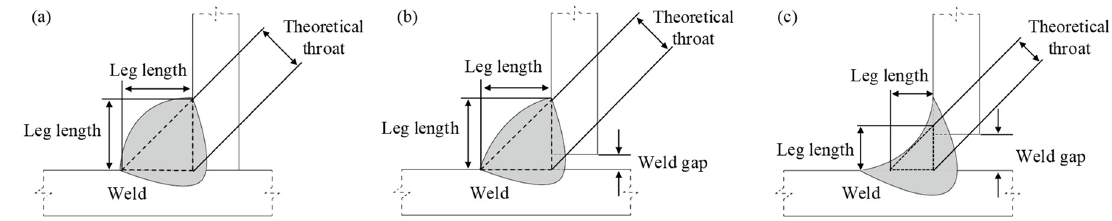
Figure 3. Welded bead shape quality parameters on the T-joint: ( a ) without weld gap and ( b , c ) with weld gap.